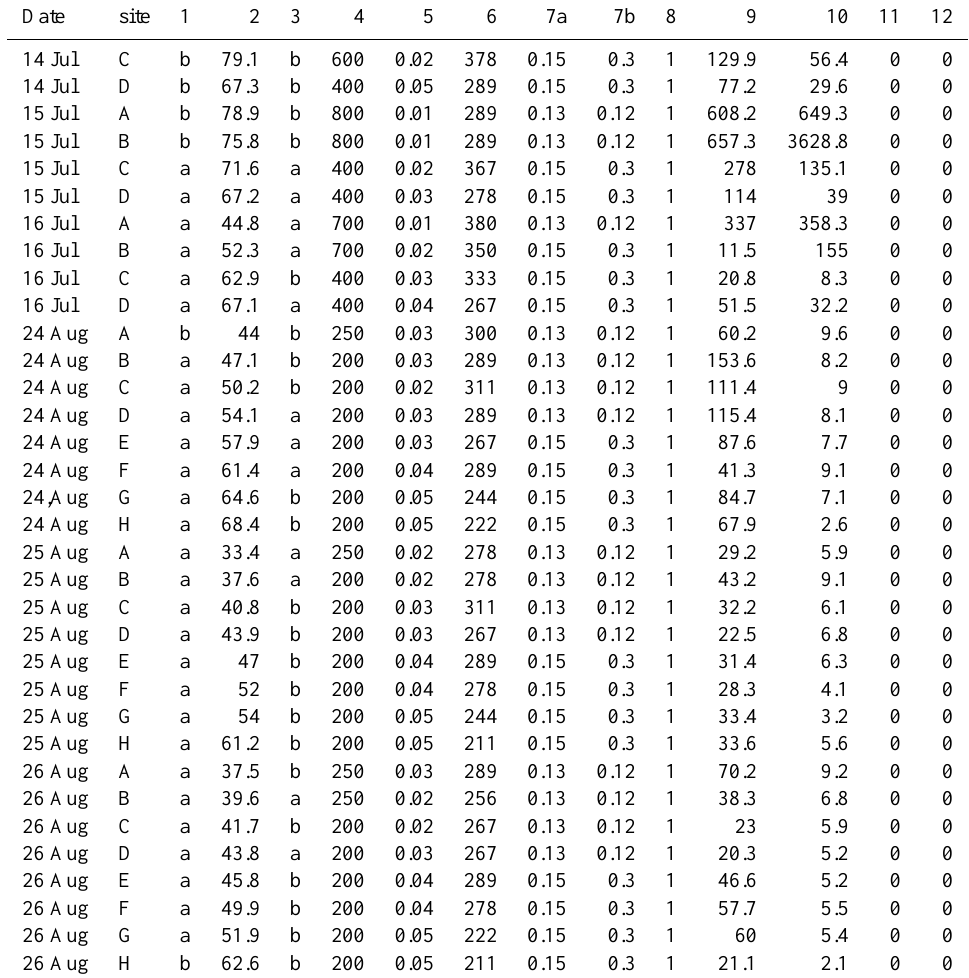
Table A1. 1. Incident radiation (a. Direct, b. Diffuse); 2. Solar zenith angle; 3. Surface spectral distribution (a. Mid-latitude winter, clear-sky, cloud amount <5. b. Mid-latitude winter, cloudy, cloud amount ≥ 5); 4. Snow grain effective radius (µm); 5. Snowpack thickness (m); 6. Snowpack density (kgm − 3 ) ; 7. Albedo of underlying ground (a. Visible, 0.3–0.7µm. b. Near-infrared, 0.7–5.0µm); 8. MAC scaling factor (experimental) for BC; 9. BC concentration (ppb, Sulfate-coated); 10. Dust concentration (ppm, 5.0–10.0µm diameter); 11. Volcanic ash concentration (ppm); 12. Experimental particle 1 concentration